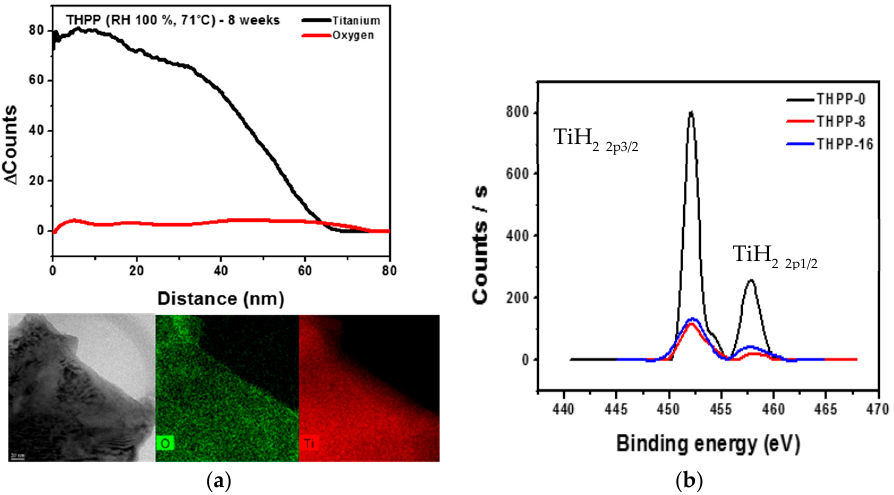
Figure 1. TEM-EDS ( a ) and XPS ( b ) characterizations of THPP under accelerated aging conditions for 8 weeks. Unlike BKNO 3 and ZPP, the formation of an oxide layer on the surface was not detected, regardless of the duration of accelerated aging.